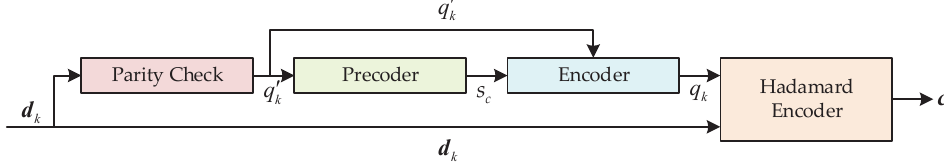
Figure 2. Flow diagram of the tail-biting convolutional-Hadamard